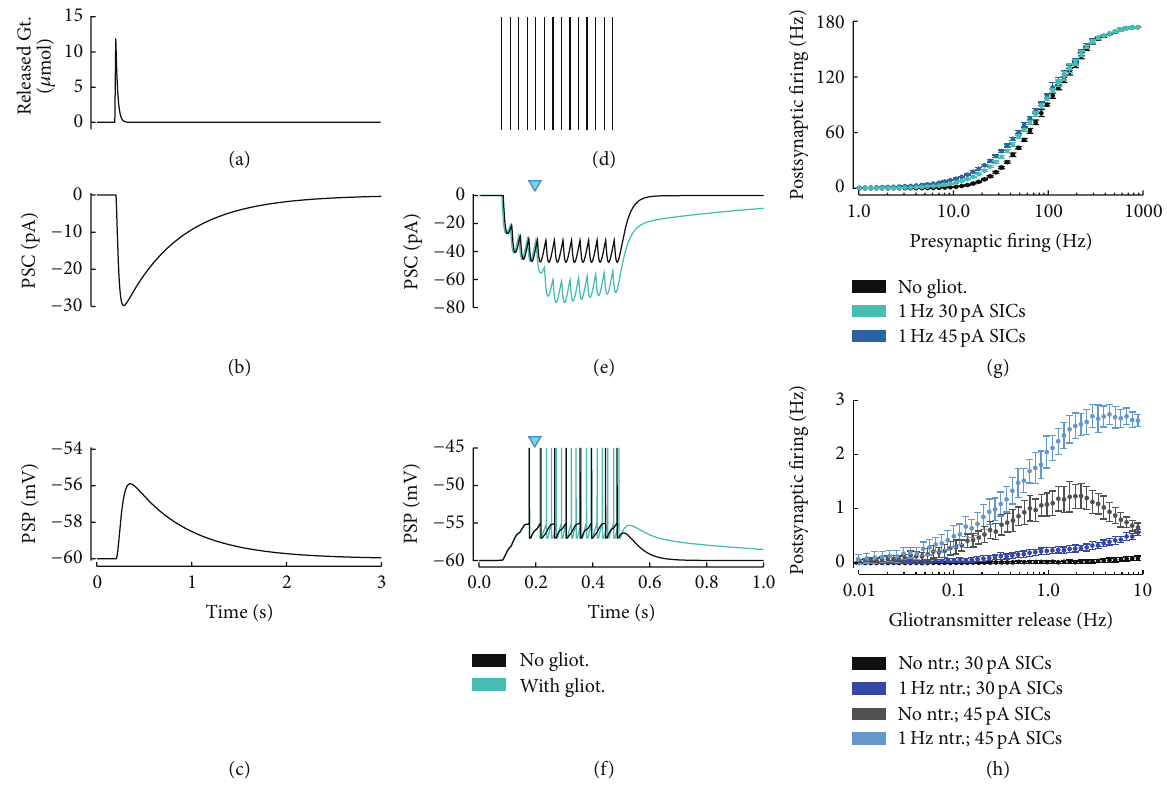
Figure 5: Postsynaptic pathway of gliotransmission by slow inward currents. The transient increase of gliotransmitter concentration in the perisynaptic space (a) triggers a slow inward (depolarizing) current (SIC) in the postsynaptic neuron ((b), (c)). Such SIC adds to postsynaptic currents triggered by presynaptic spikes ((d), (e), cyan triangle marks gliotransmitter release/SIC onset) and may dramatically alter postsynaptic firing (f). In general postsynaptic firing frequency increases with both SIC amplitude (g) and frequency (h). In this latter case, however, SICs as ample as 30 pA (similar to what reported in several experiments) need to impinge on the postsynaptic neuron at unrealistically high rates ( ≫ 0.1Hz) in order to trigger a sensible change in the neuron’s firing rate ( black data points ). Lower, more realistic SIC rates may affect neuronal firing only for larger SIC amplitudes (e.g., 45pA, grey data points ). The entity of SIC-mediated increase of postsynaptic neuronal firing further depends on the neuron’s state of depolarization at SIC timings which is set by synaptic inputs ( blue and cyan data points ). Data points and error bars: mean ± STD out of 𝑛 = 50 simulations with presynaptic Poisson-distributed spike trains. Parameters as in Table 1 except for 󰜚 𝑒 = 10 −4 , 𝜏 𝑒 = 200 ms, 𝜏 𝑟 𝑆 = 10 ms, and 𝑅 in = 150 M Ω